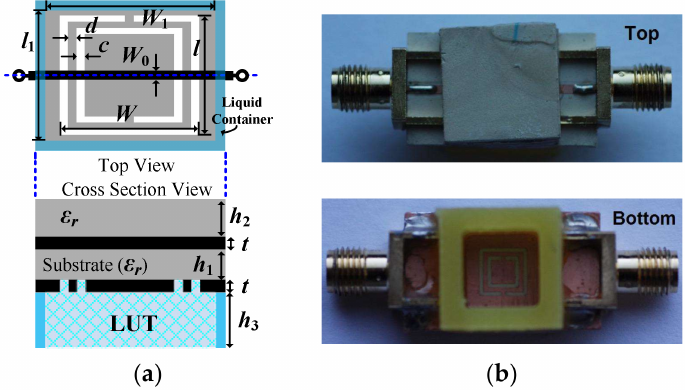
Figure 1. Top and cross-section views ( a ) and photograph ( b ) of the complementary split ring resonator (CSRR)-loaded embedded microstrip line. Dimensions are: W = l = 5.92 mm, c = d = 0.5 mm, W 0 = 1.15 mm, W 1 = l 1 = 9.92 mm, h 1 = 1.27 mm, h 2 = 3.81 mm, h 3 = 7.2 mm, and t = 35 µ m. The